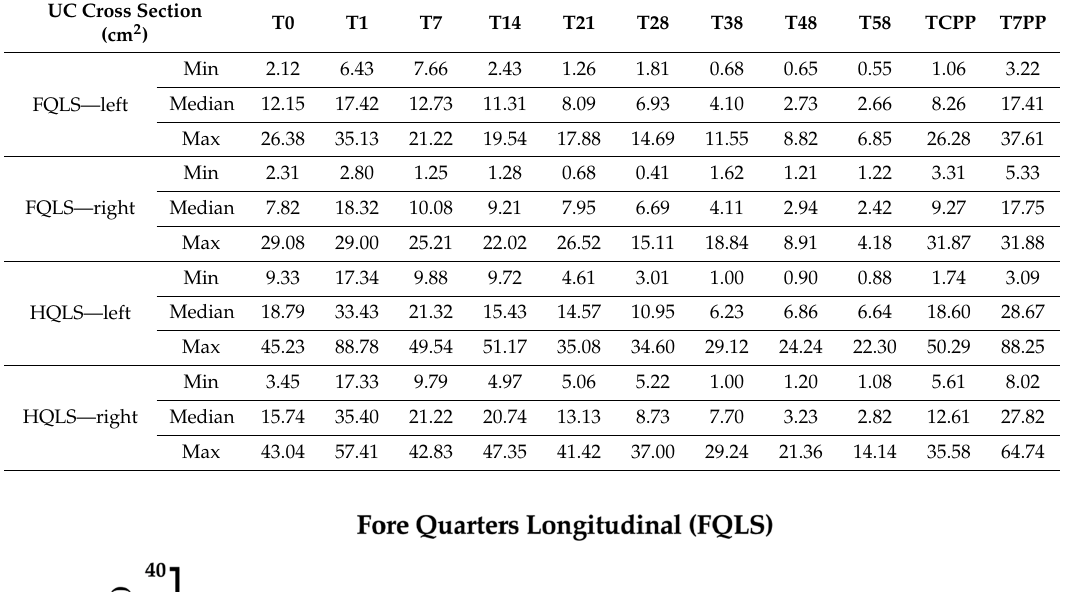
Table 2. The median, maximum (Max) and minimum (Min) values of the size (area) of the udder cistern (UC) for the front (FQ) and hind (HQ) left (-L) and right (-R) quarters in the cross section for T0, T1, T7, T14, T21, T28, T38, T48, T58, T colostrum production phase (TCPP) and T 7 days post-partum (T7PP).